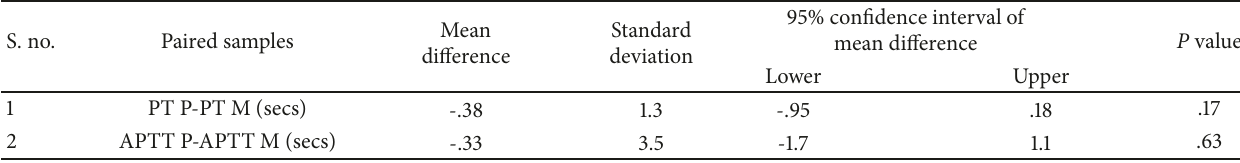
Table 2: Summary of the differences in PT and APTT between pneumatic tube samples and hand delivered samples. S.